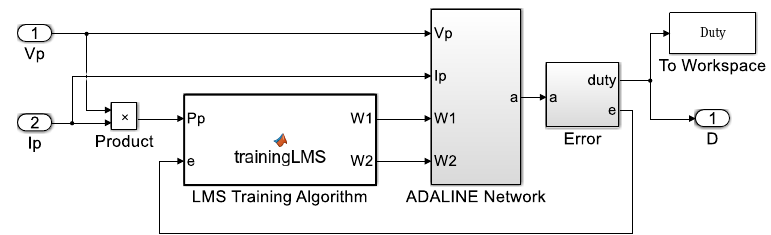
Figure 8. Flow diagrams: ( a ) Iterative LMS Algorithm; ( b ) Iterative LMS Controller.